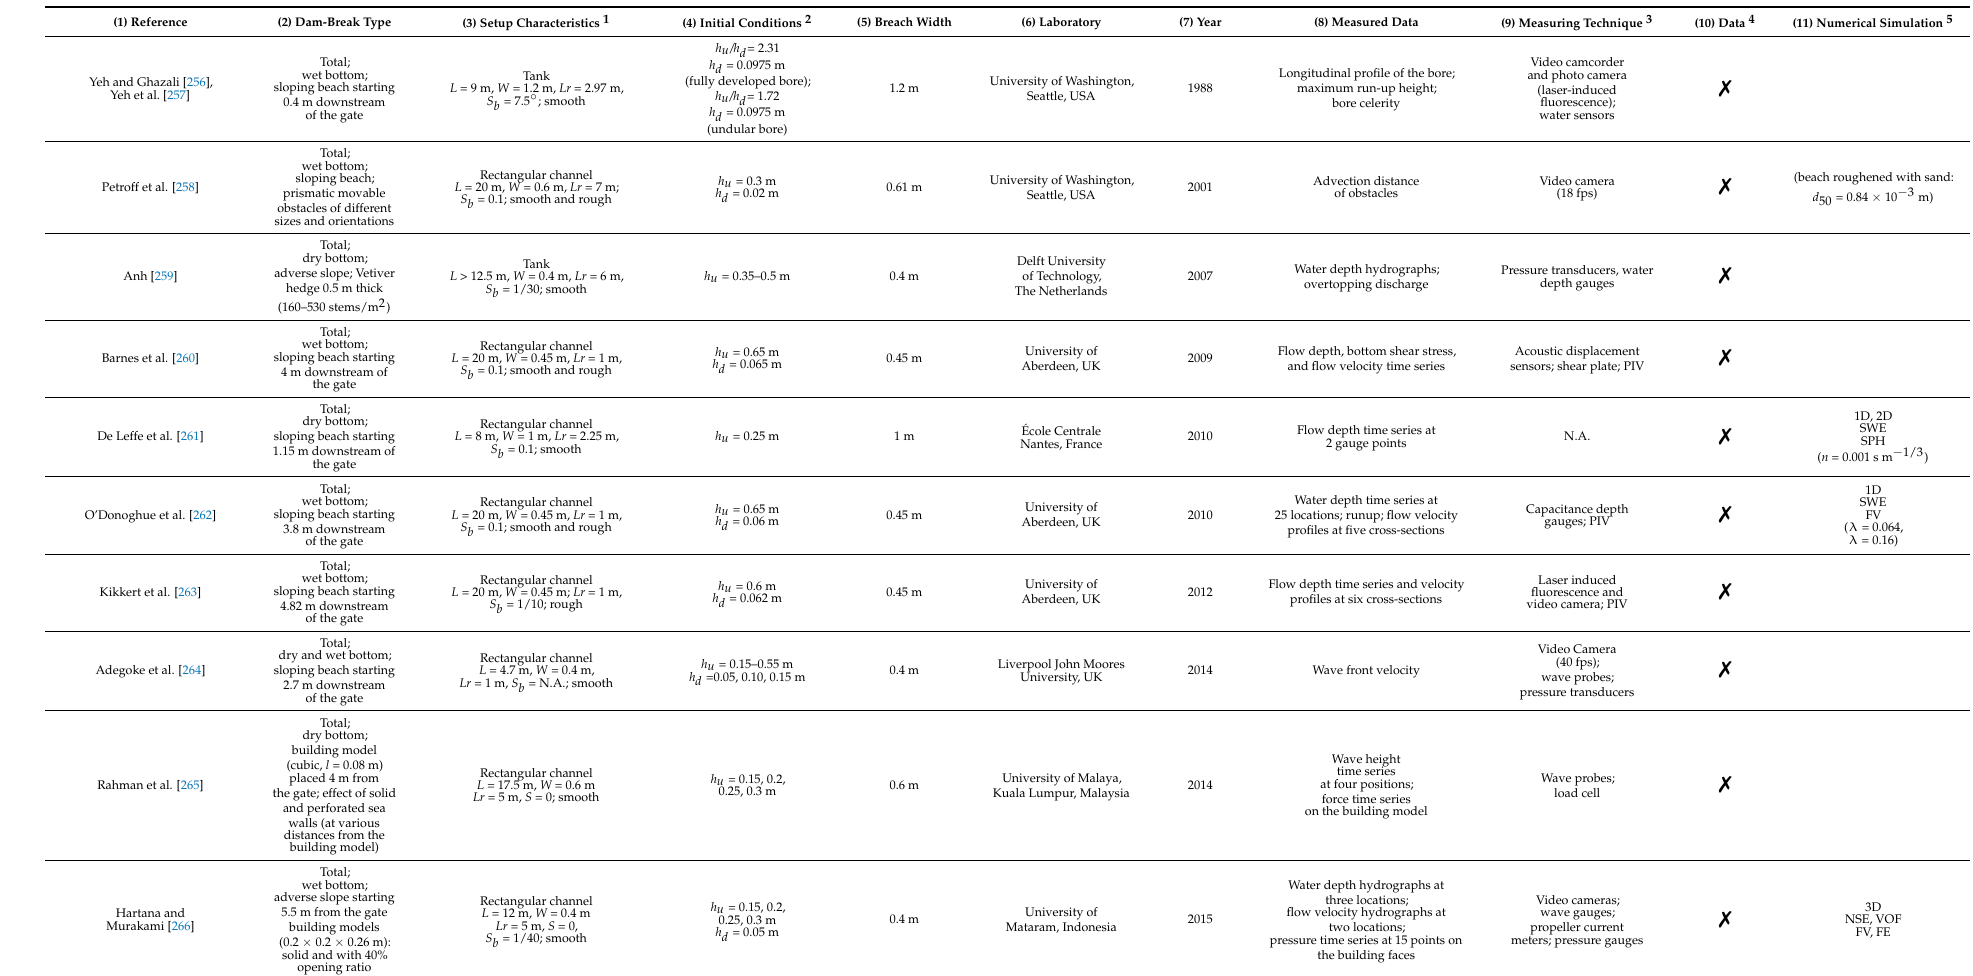
Table 5. Experimental investigations of the propagation of tsunami bores (generated by the removal of a gate) in the swash zone. Table 1. Basic experimental investigations of fundamental dam-break wave physical characteristics.